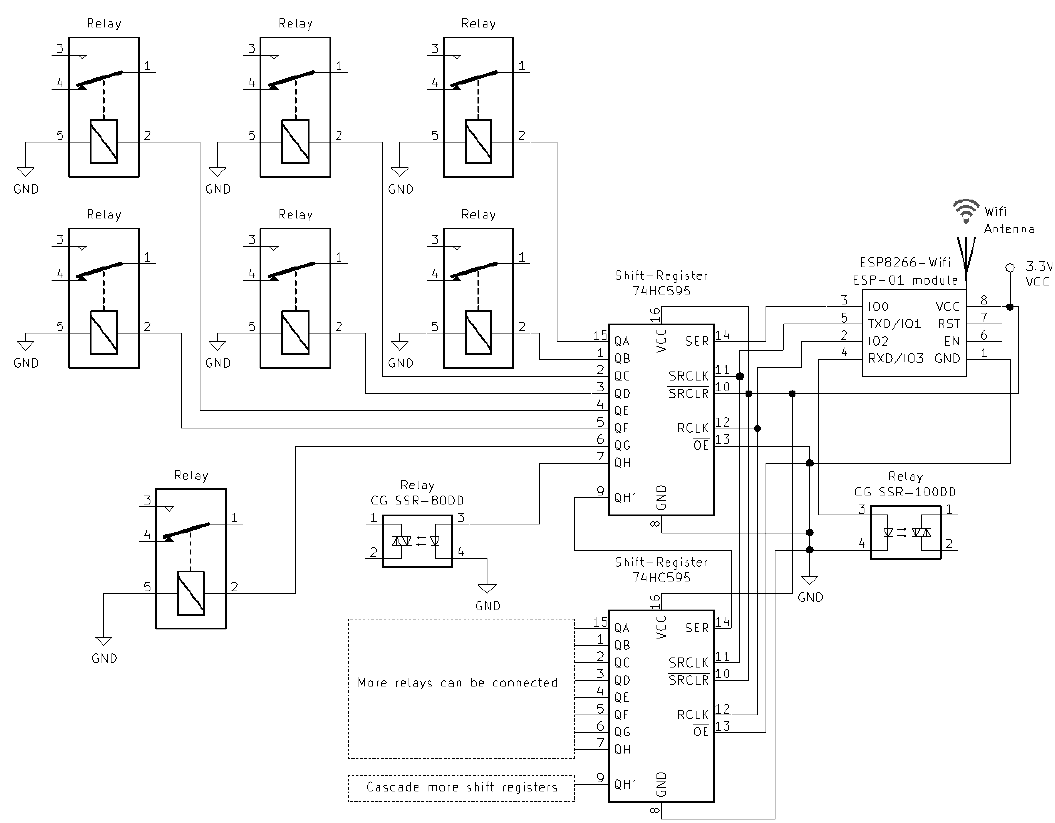
Figure 4. IoTBC circuit diagram. The circuit shows how IoTBC utilized the ESP-01 module and how it could be connected to control as many breaker units (relays) as required.